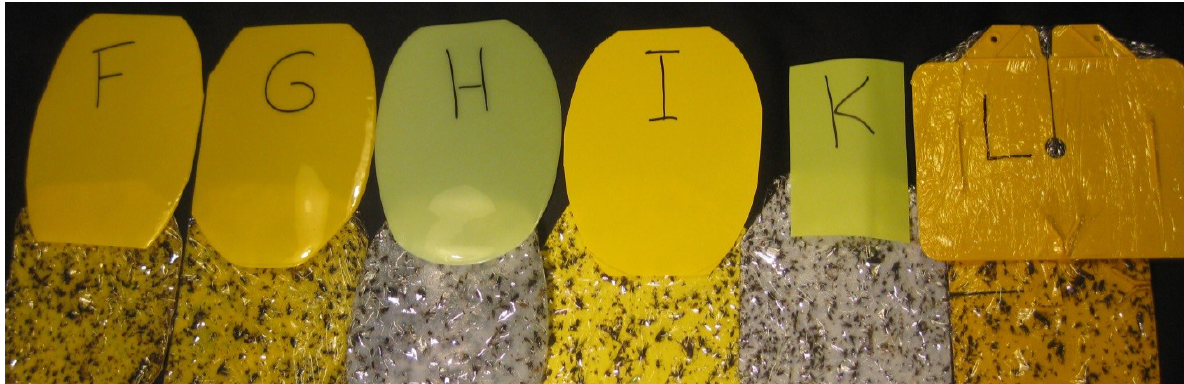
Figure 5. The color of trap types before and after the experiment (trap Type L = Rebell ®